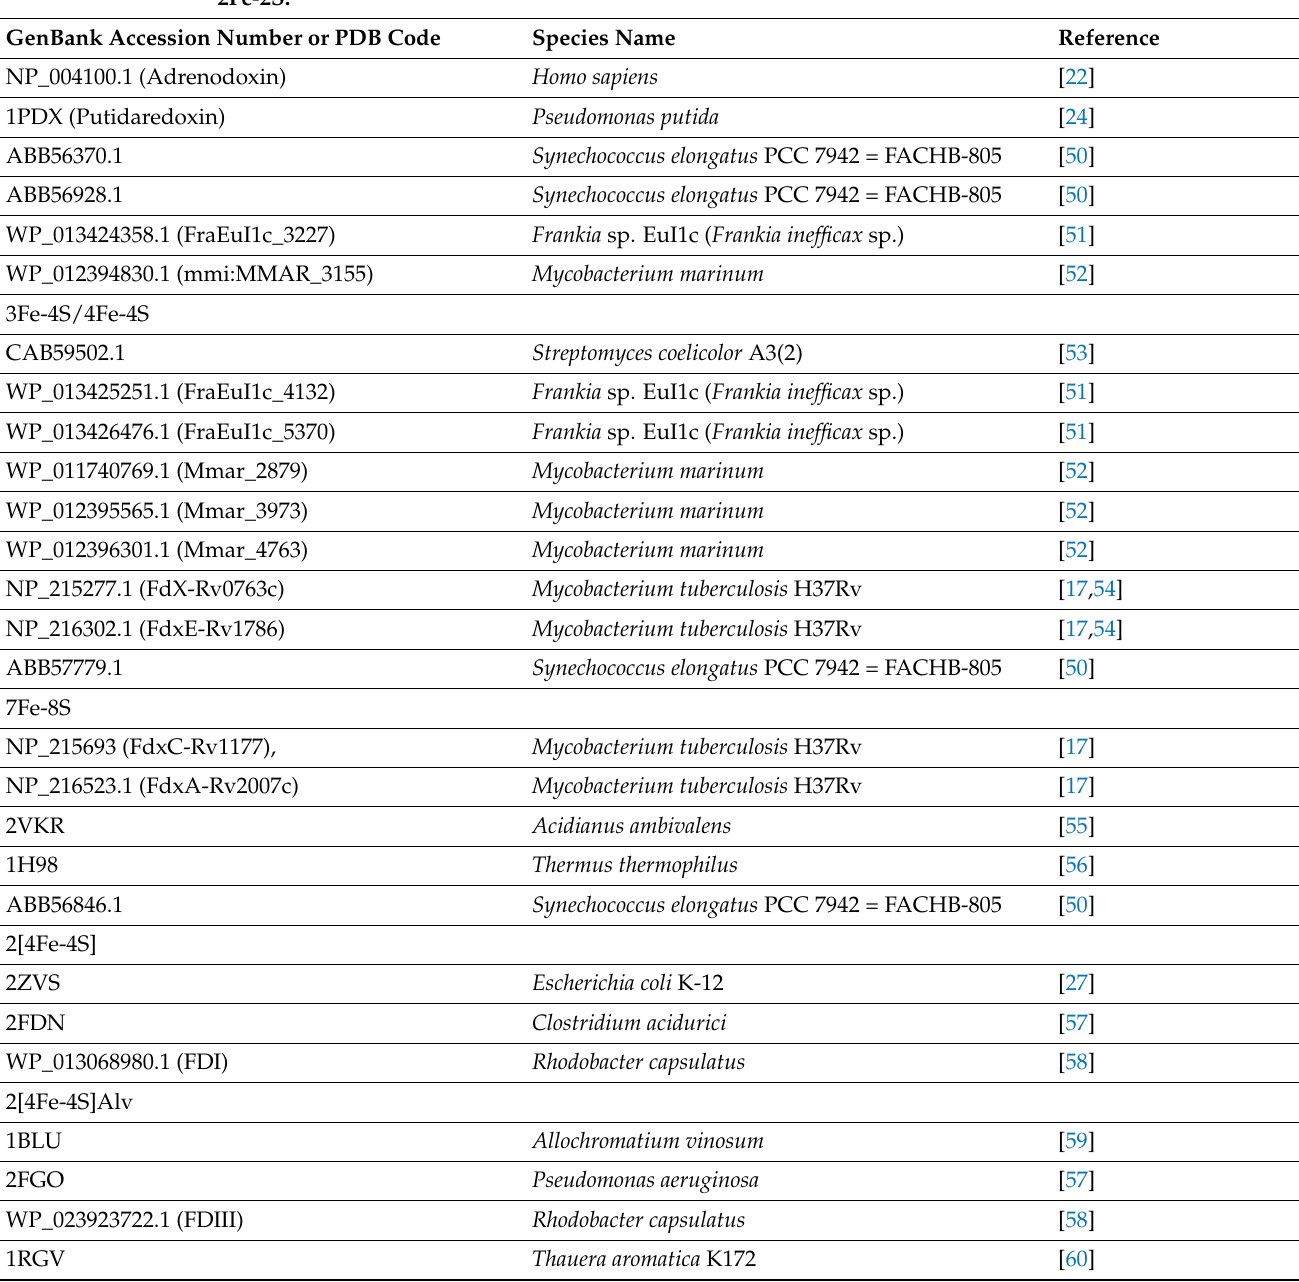
Table 1. Information on ferredoxins that are used as reference proteins for datamining of ferredoxins in the bacterial species of Alphaproteobacteria and Firmicutes .